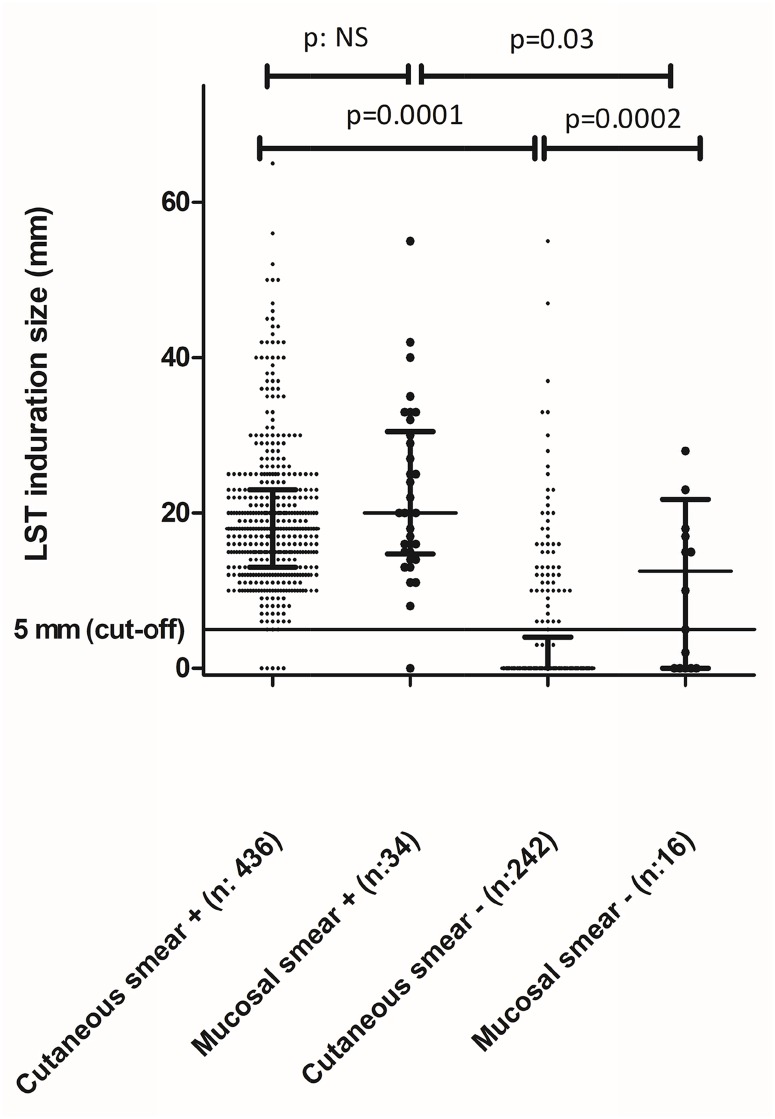
Leishmanin Skin Test (LST) induration among 733 individuals with diagnostic work up classified according to clinical form and result of lesion’s smear.Median and inter quartile range error bars drawn for each group. P values between groups calculated with Mann Whitney´s test.